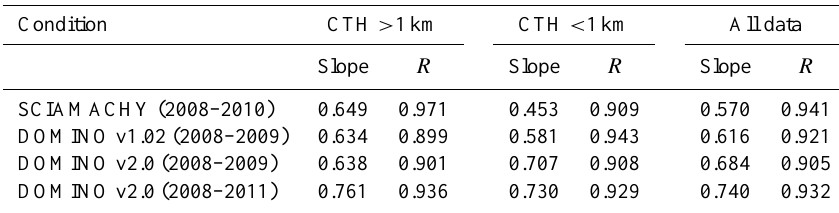
Table 5. Regression results using the MAX-DOAS measurement data versus coincident SCIAMACHY and OMI satellite data (DOMINO v1.02 and v2.0) for various cloud top height (CTH) conditions, as shown in Fig. 14.